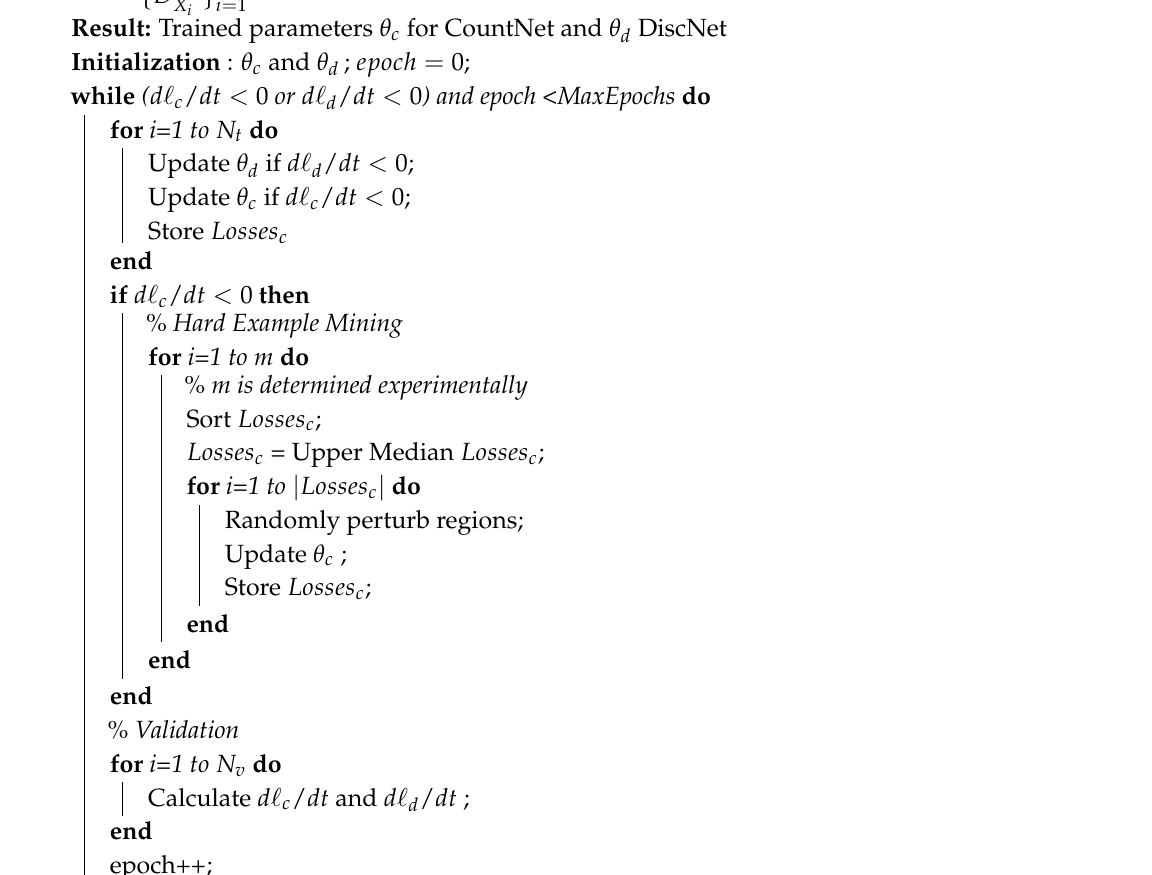
Algorithm 1: DisCount training algorithm is illustrated here. Data: N t training images; N v validation images; { X i } N { D GT } N X i i = 1